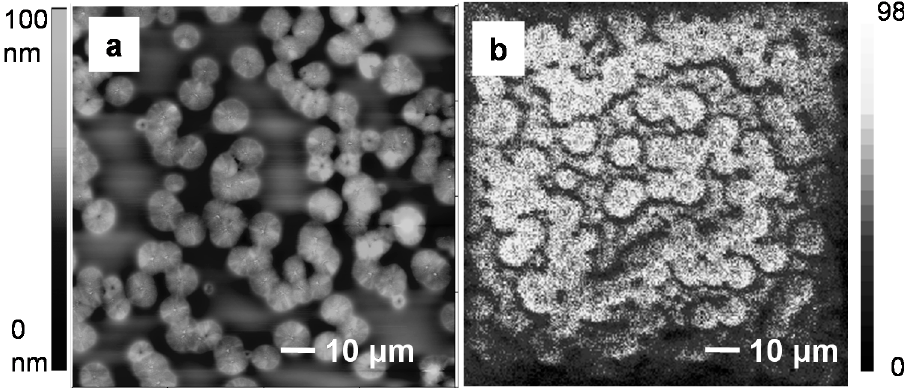
Figure 5. AFM height image ( a ) and the corresponding ToF-SIMS F − image ( b ) for the BA-C8/6FBA-C8 (80/20) blend 68 h after it was prepared [42].